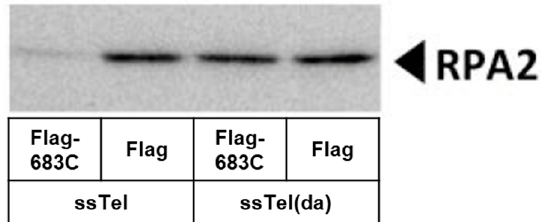
Figure 6. hnRNP U prevents RPA2 from binding telomeres. Flag-hnRNP U 683C fusion proteins made in E. coli were IP:d with anti-Flag agarose gel. Genome DNA derived from E. coli was removed from IP and mixed with mouse embryonic stem cell extract and whole cell extract (WCE) and ssTel or ssTel(da) oligonucleotides. After centrifugation, each oligonucleotide in the supernatants was pulled down with streptavidin magnetic beads. RPA2-bound oligonucleotides were detected by Western blot with anti-RPA2 antibody.